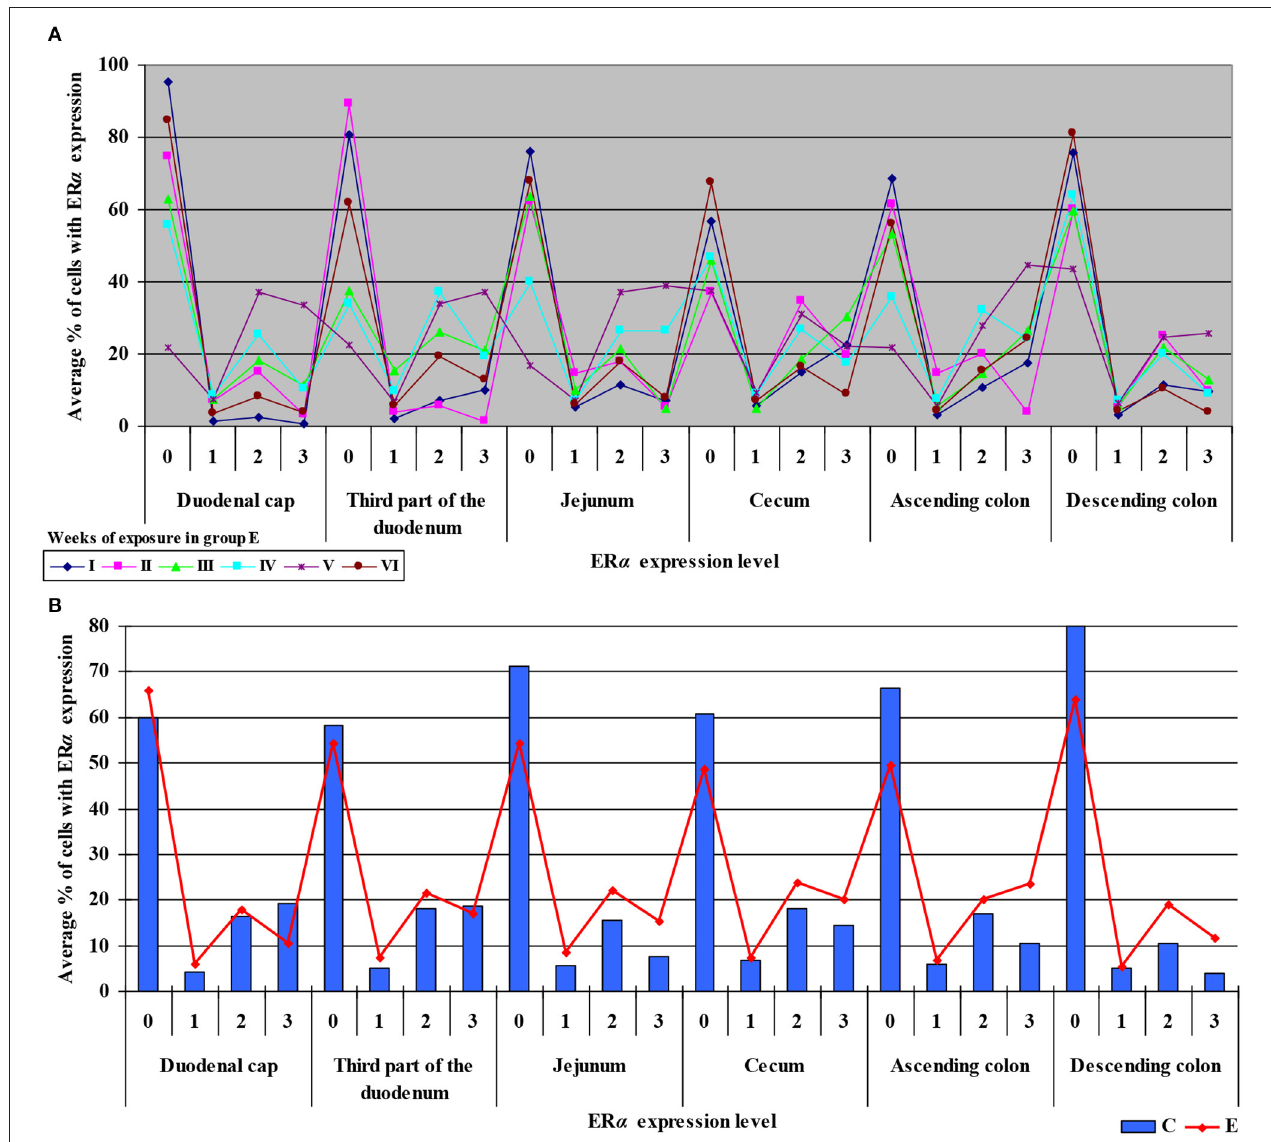
FIGURE 4 | Immunohistochemical expression of ER α in the control and exposed groups (graded on a 4-point scale: negative = 0 points; weak and homogeneous = 1 point; mild or moderate and homogeneous = 2 points; intense or strong and homogeneous = 3 points) in different intestinal segments and in selected weeks of exposure: (A) in group E; (B) average expression values from all weeks of exposure in both